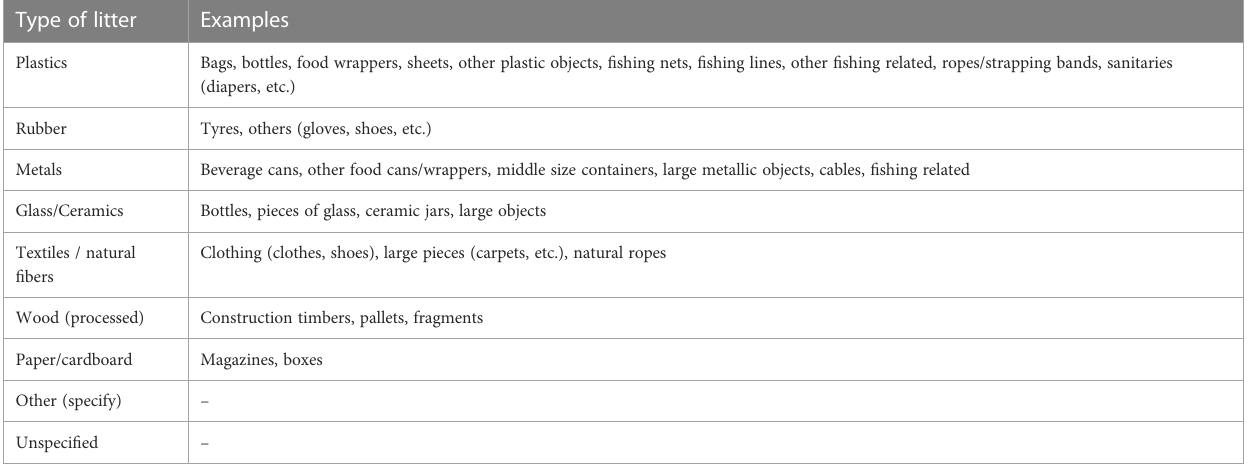
TABLE 2 Litter categories of the Guidance on Monitoring of Marine Litter in Mediterranean Sea (European Commission of the European Union, 2013). Type of